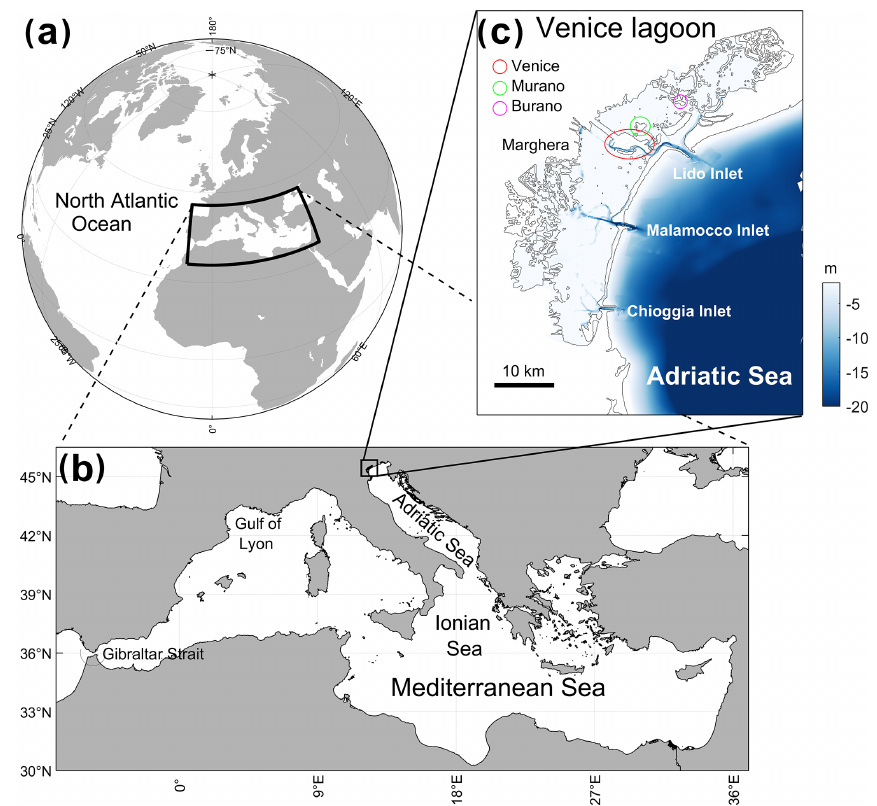
Figure 3. The lagoon of Venice in the global context. (a) The Mediterranean Sea is connected with the North Atlantic Ocean through the Strait of Gibraltar. (b) The Venetian Lagoon is located along the northern coast of the Adriatic Sea, a subbasin of the eastern Mediterranean Sea. (c) The historic centre of Venice (indicated) is located in the middle of the Venetian